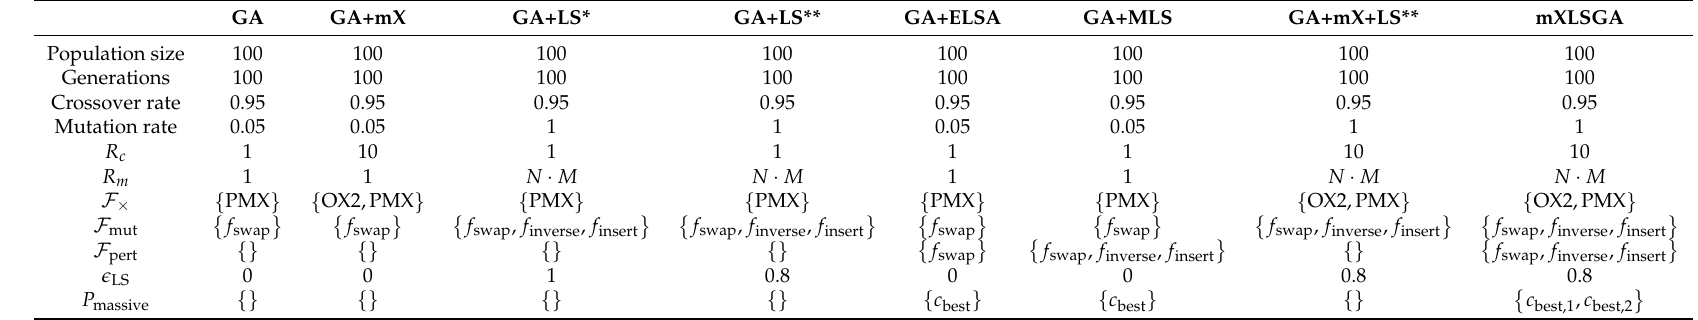
Table 2. Set up for case study I. Where c best is the best individual in the population and c best,1 and c best,2 are the two best individuals in the population who are different.